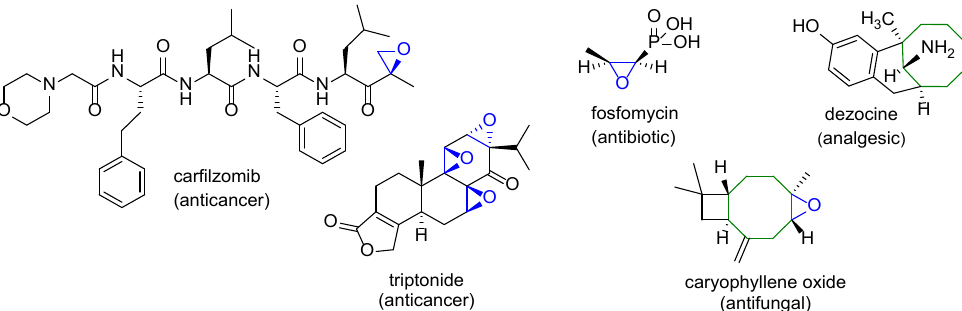
Figure 1. Examples of marketed drugs and bioactive compounds containing oxirane or cyclooctane